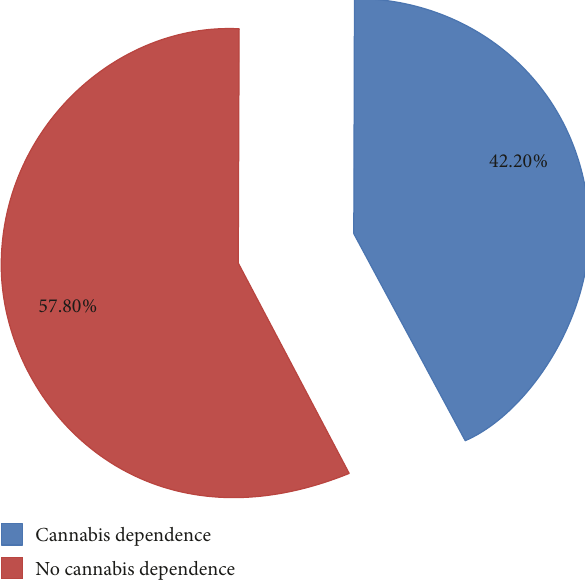
Figure 1: Prevalence of cannabis use disorder among young adults at Shashemene Town, Oromia Region, Ethiopia,